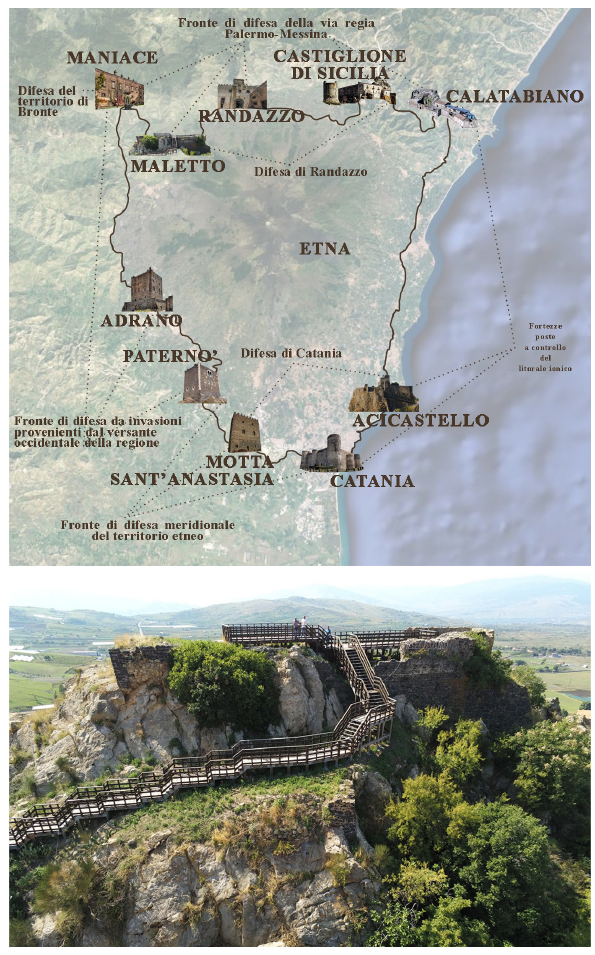
Figure 1 . The so called Frederician Etna Route and the Maletto Castle, in Sicily